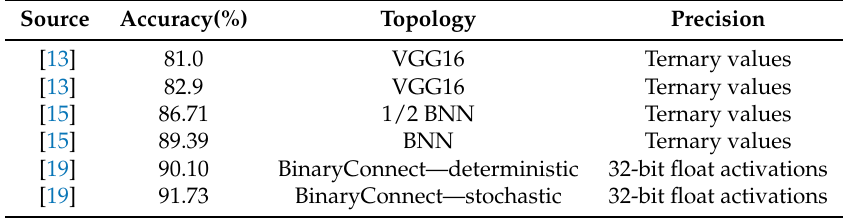
Table 10. Accuracies on the CIFAR-10 dataset of non-binary networks related to works reviewed.